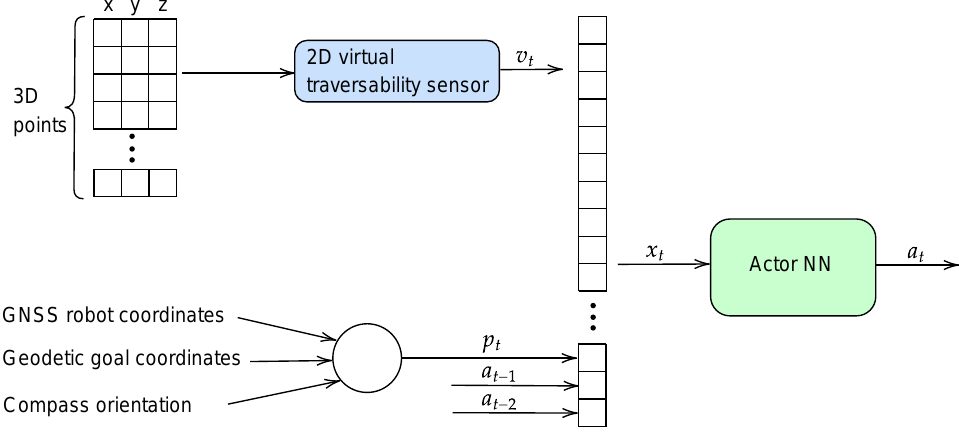
Figure 10. Inputs and outputs of the Actor NN during autonomous